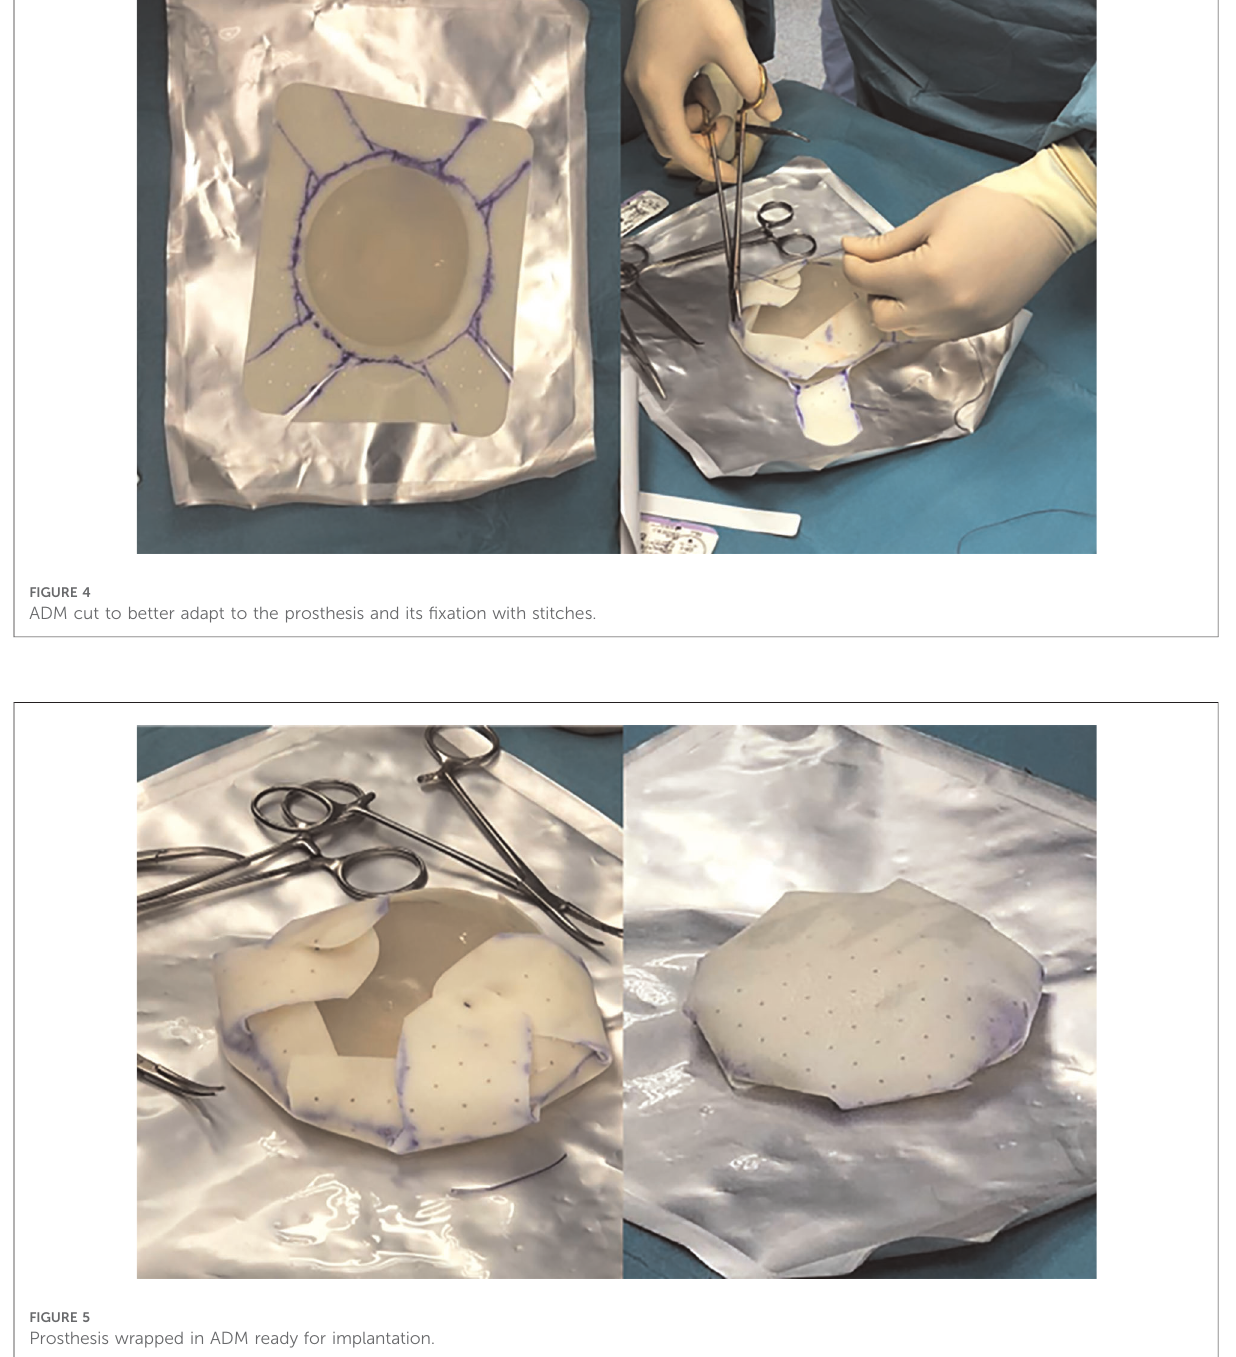
signi fi cant differences between the different groups about individual complications. Therefore, in terms of occurrence of individual complications, the different techniques do not differ signi fi cantly ( Table 2 ).